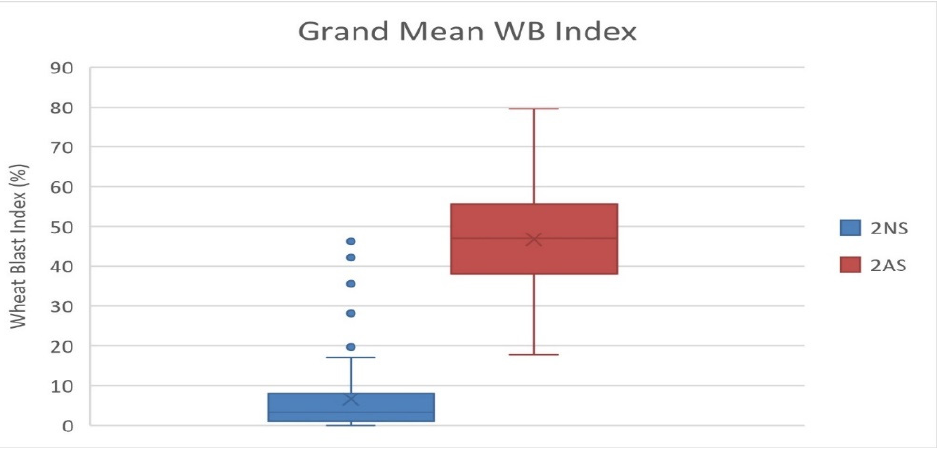
Figure 5. Boxplot for phenotypic variation in the 2NS vs. 2AS genotypes based on grand mean WB data over 12 experiments. data over 12